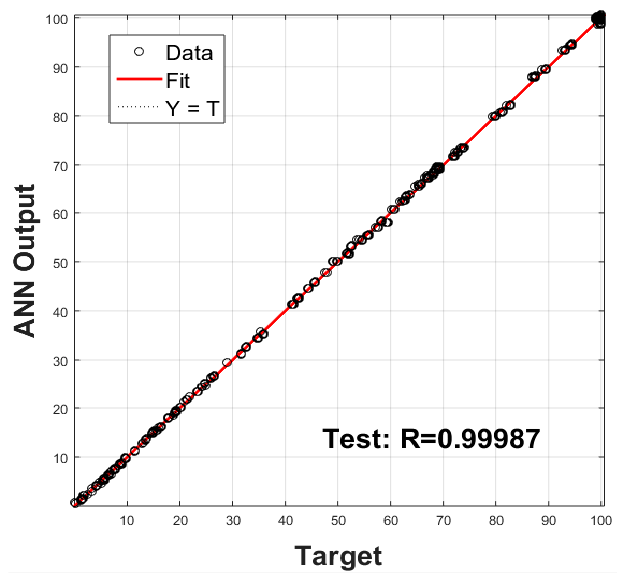
Figure 14. Comparison between simulated data and the values obtained by the ANN.